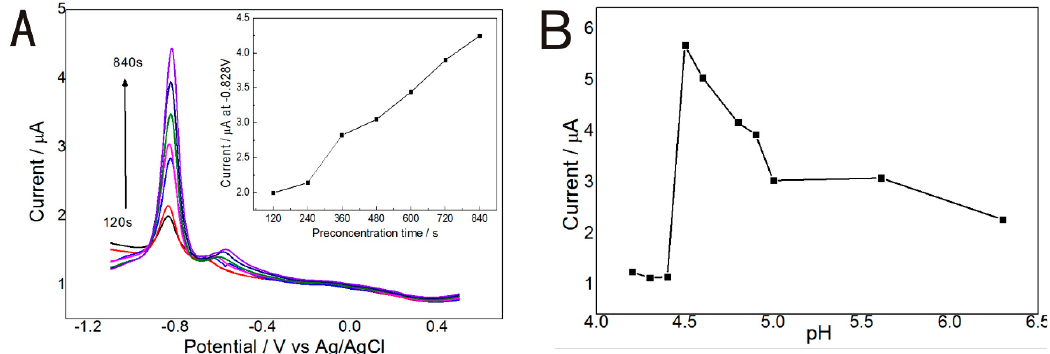
Figure 4. Effect of deposition time ( A ) on the differential pulse stripping voltammetry (DPSV) peak current of 10 µg/L Cd(II) at pH 4.50. Effect of pH ( B ) on the DPSV peak current of 10 µg/L Cd(II) with deposition time of 360 s.